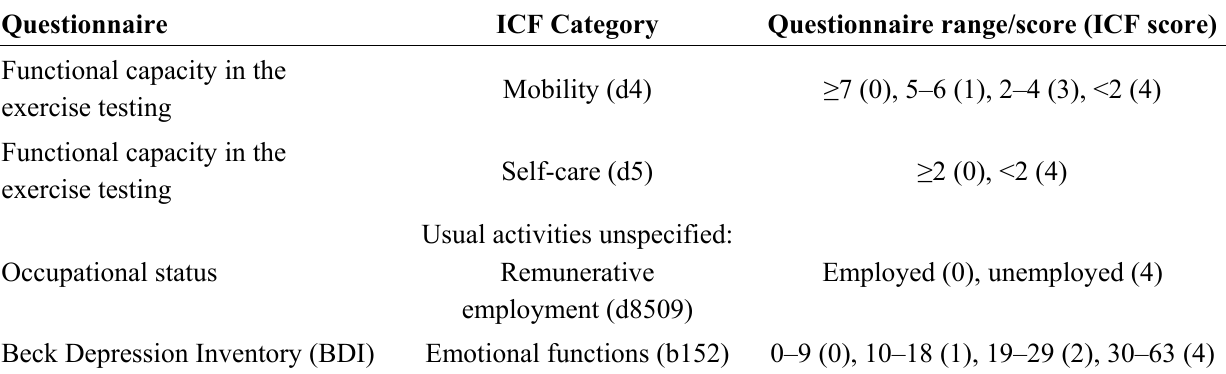
Table 5. Mapping of questionnaires into ICF.